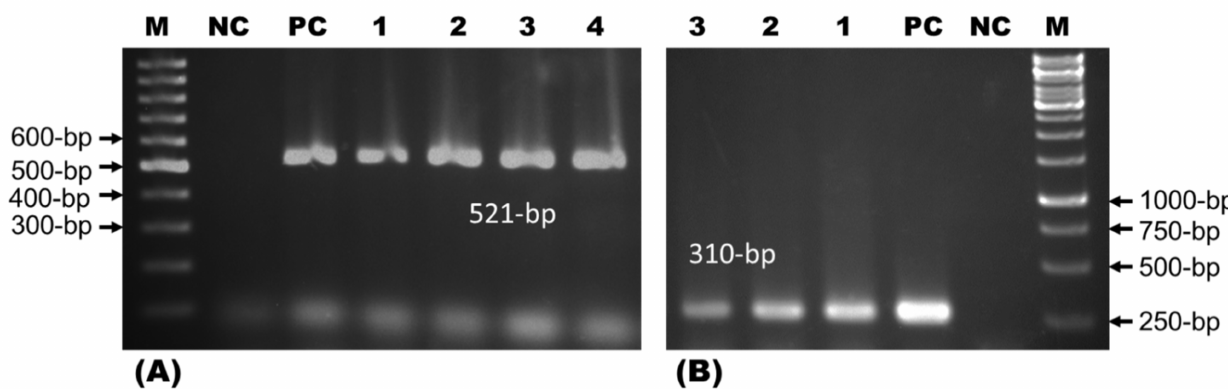
Figure 5. Identification of Aspergillus sp. and Aspergillus niger by polymerase chain reaction. ( A ) PCR identification of Aspergillus sp. by using genus-specific primers. Lane M- 100-bp DNA ladder, NC: negative control, PC: positive control, and lane 1–4 test samples. ( B ) PCR identification of Aspergillus niger by using specific primers. Lane M—1 Kb DNA ladder, NC: negative control, PC: positive control, and lane 1–3 test